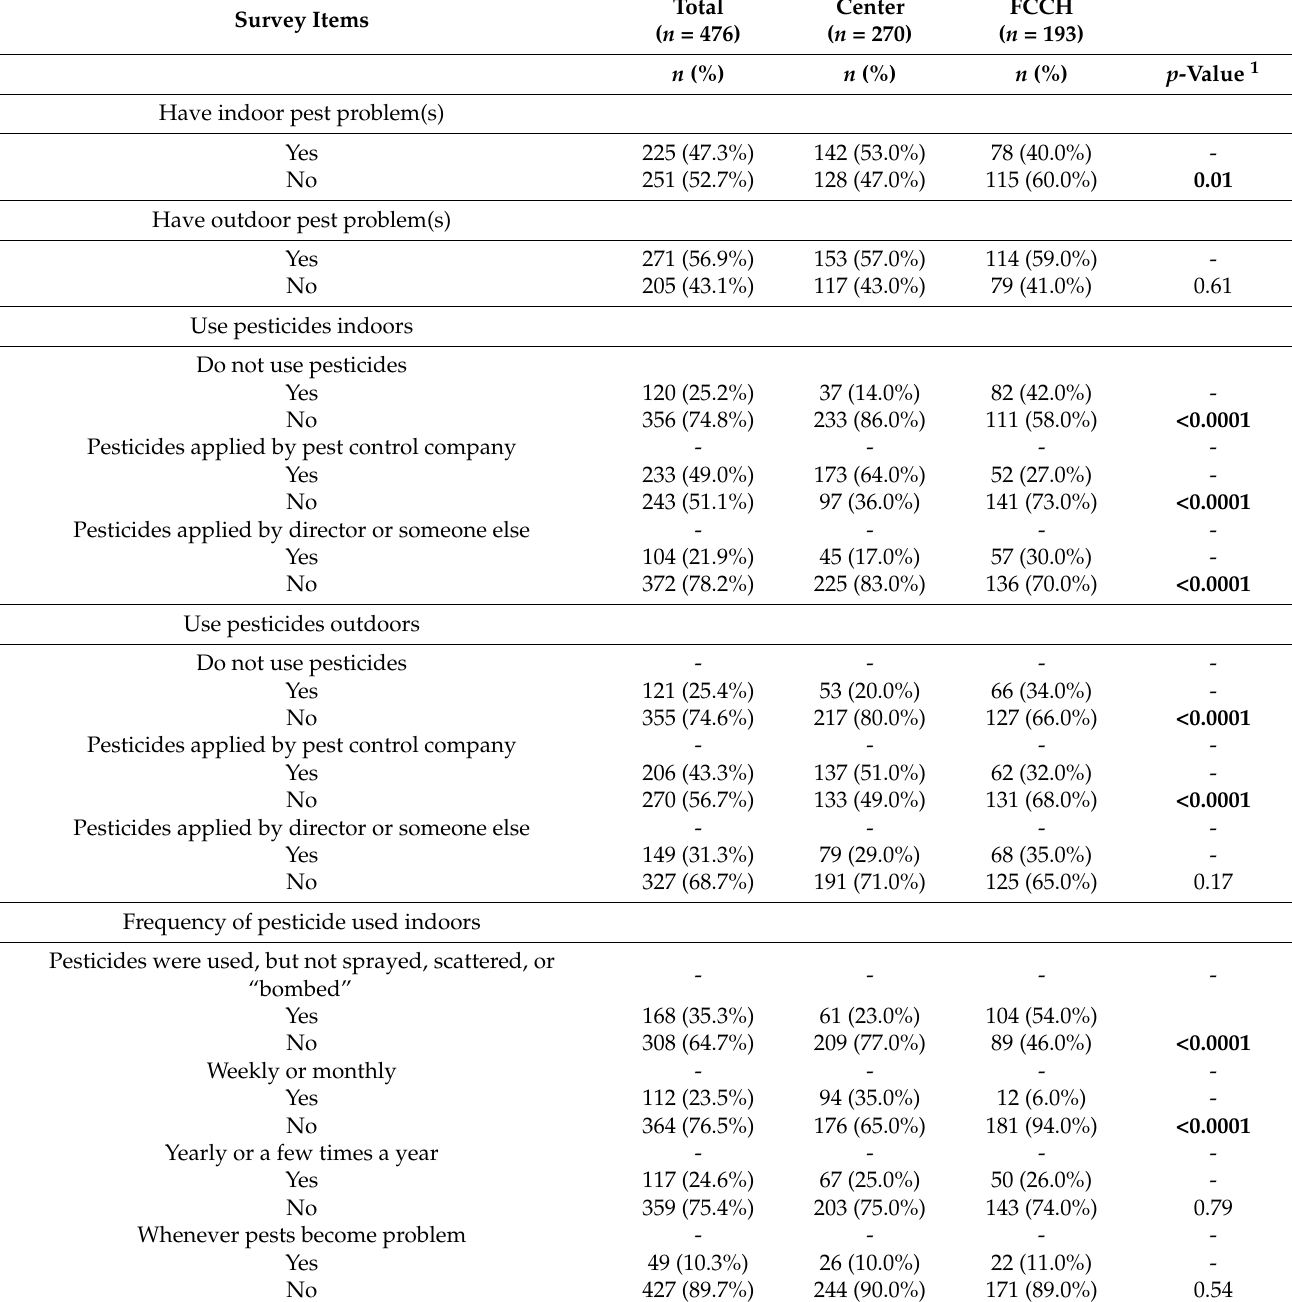
programs used a pest control company for outdoor pesticide applications at their facilities, with Centers reporting doing so more often than FCCHs (51.0% versus 32.0%, p < 0.0001). A small proportion (21.8%) of ECE programs had a written policy about pesticide use. Centers were more likely than FCCHs to have a written pesticide use policy (31.0% versus 8.0%, p < 0.0001). Over one-in-three (36.7%) programs reported notifying parents before applying pesticides. Centers (29.0%), however, were less likely than FCCHs (42.0%) to notify parents before pesticide applications inside or outside their facility ( p = 0.01). Table 4. Reported pest problems, pest control methods, applicators, frequency, and related topics for all early care and education programs, centers, and family childcare homes (FCCHs), Oklahoma